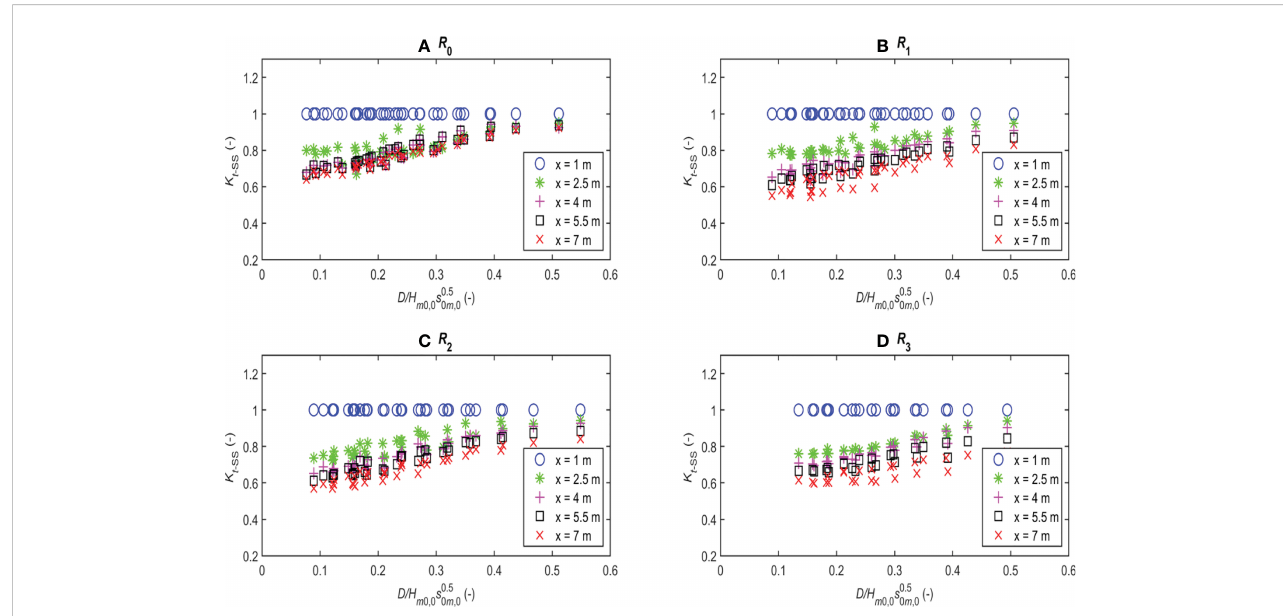
FIGURE 5 Transmission coef fi cient K t-SS versus relative submergence for SS-waves: (A) Smooth reef; (B) Crushed stone reef 1; (C) Crushed stone reef 2; (D) Simulated coral